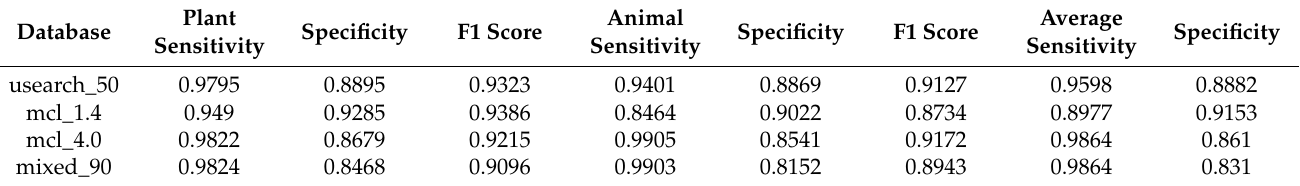
Table 4. Sensitivity, specificity, and average scoring values for the four top performing candidate databases after e-value filtering (0.001) of